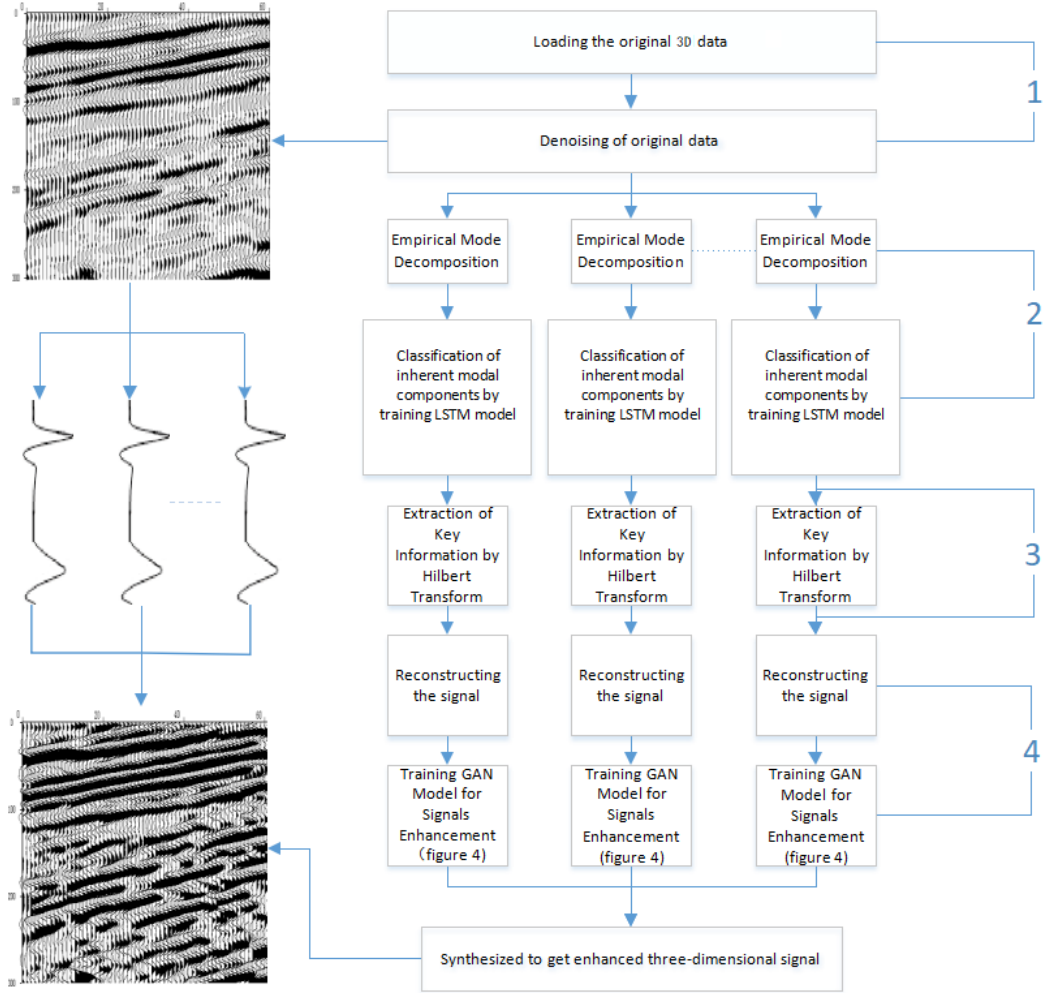
Figure 1. Flow chart of the weak signal reconstruction method under the neural network-assisted empirical mode decomposition (EMDNN) model.